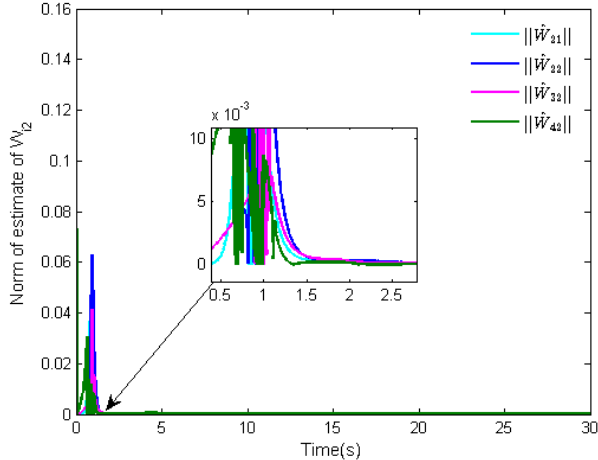
Figure 16. The curves of the norm for the adaptive control law ˆ W i 2 The curves of the output